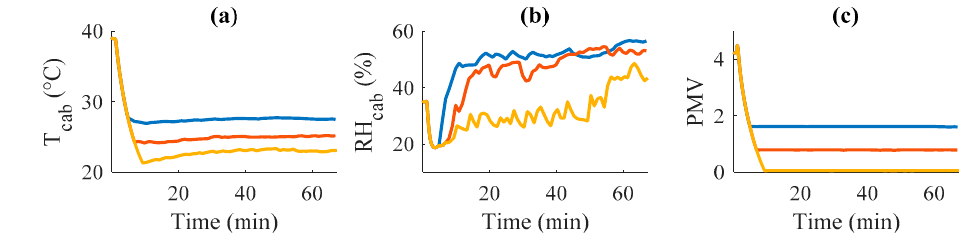
Figure 14. Cabin results for three initial SOCs: ( a ) PMV, ( b ) Temperature, ( c ) Relative humidity.